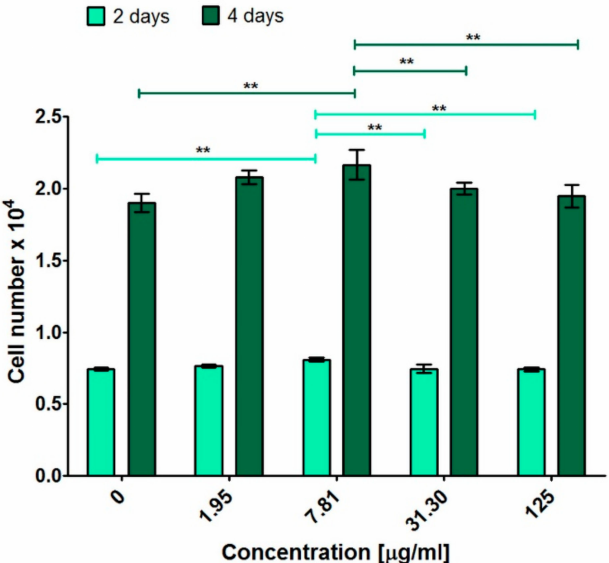
Figure 7. Human osteoblast proliferation (hFOB 1.19 cell line, ATCC CRL-11372 TM ) after 2-